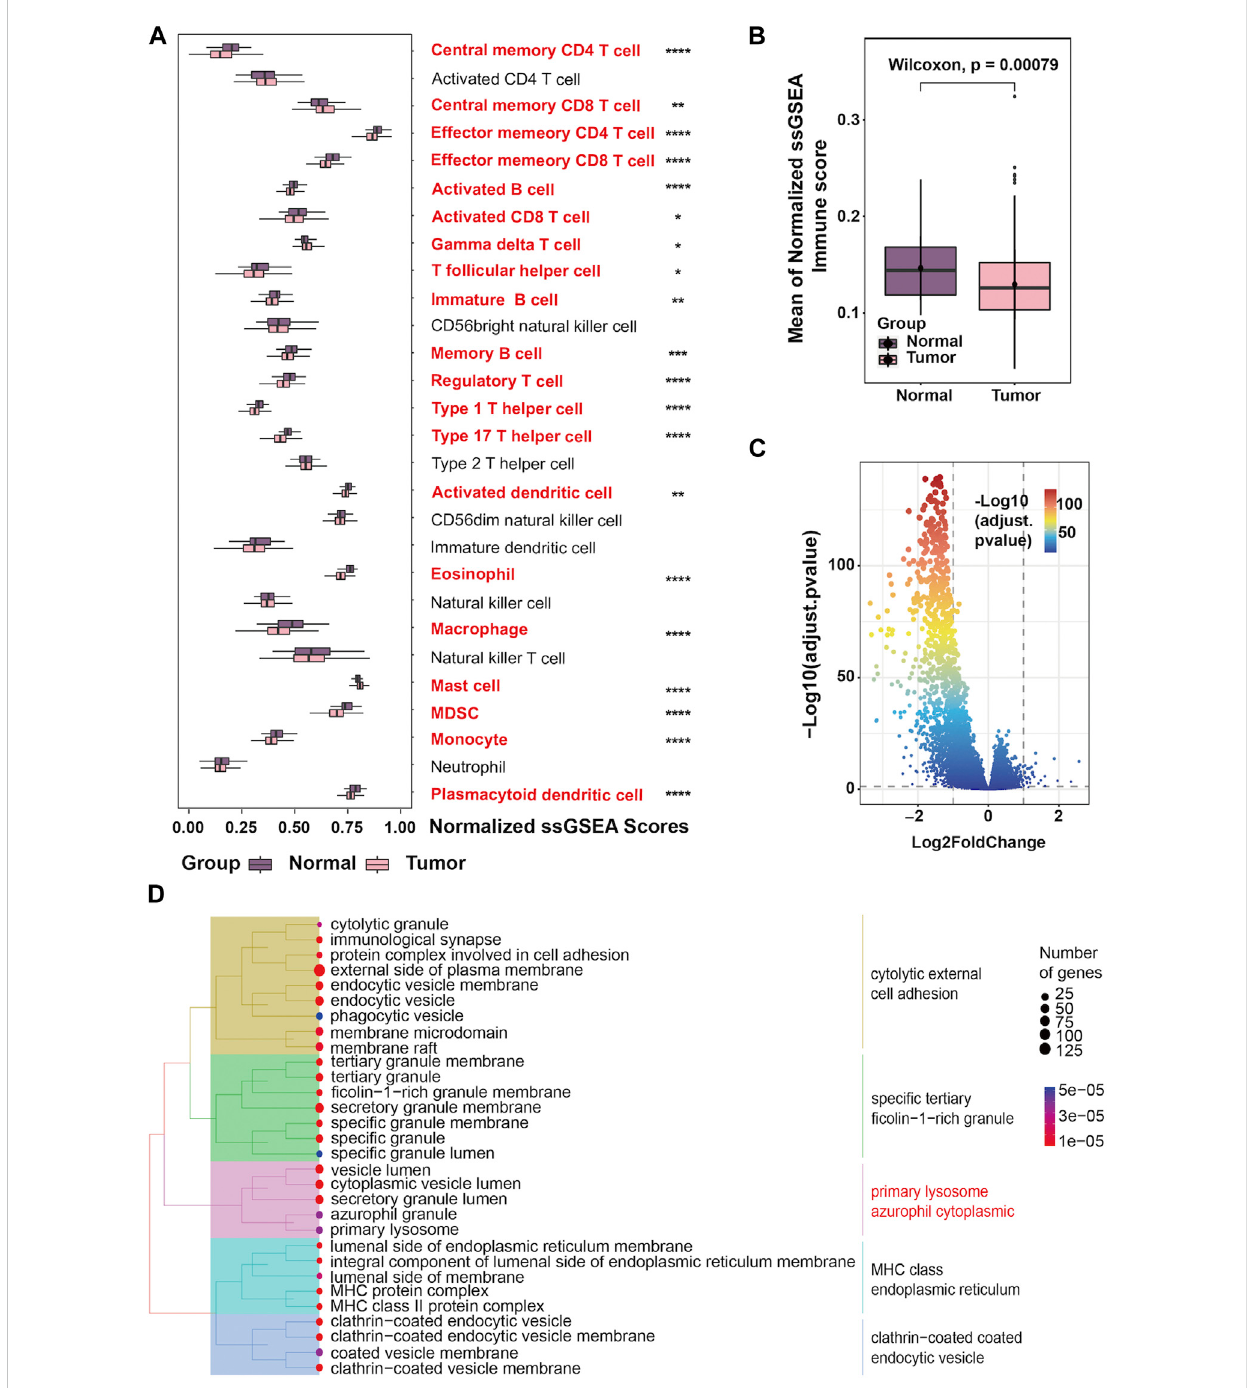
FIGURE 1 Landscapeofthetumorimmunemicroenvironmentinprostatecancer (A) Thedifferenceintheenrichmentscoreof28immunecelltypesbetween normalandtumorsamples; (B) Boxplotsshowingoverallimmunescoresbetweennormalandtumorsamples; (C) VolcanoplotexhibitingDEGsbasedon immune score classi fi cation; (D) Tree plots of the GO enrichment analysis of DEGs based on immune score classi fi